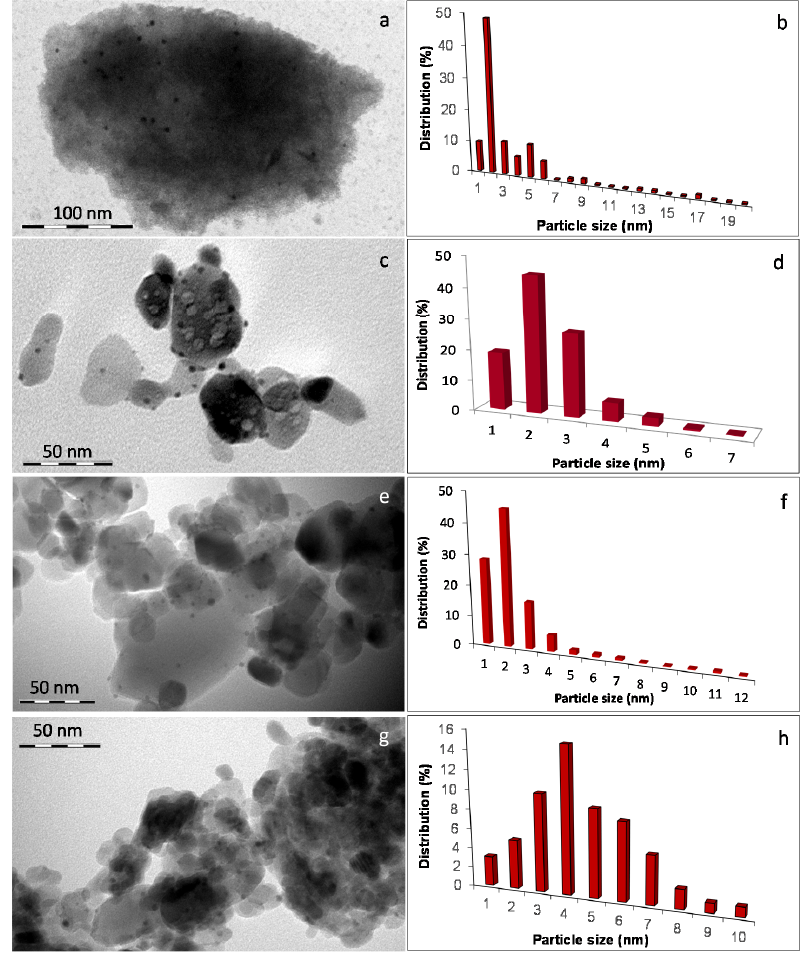
Figure 4. HRTEM images and their corresponding size distribution histograms of Au nanoparticles in ( a , b ) Au/Al 2 O 3 , ( c , d ) Au/Fe 2 O 3 , ( e , f ) Au/TiO 2 , ( g , h ) Au/ZnO. Histograms adapted from [5] with permission from Wiley. Table 2. Characterization of the supported Au materials a .